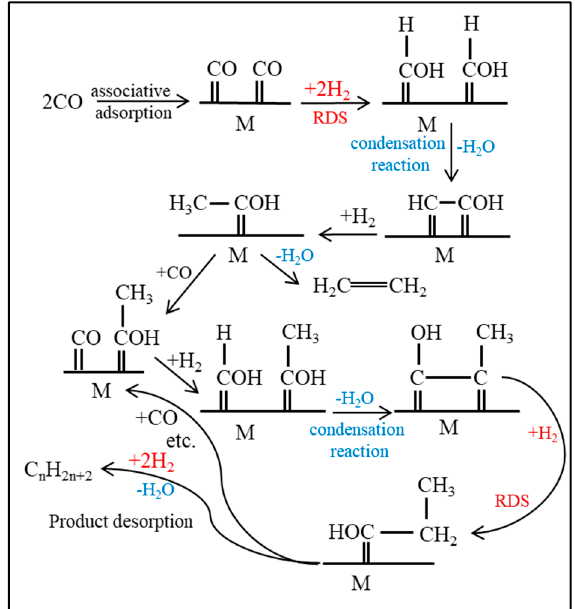
Figure 4. A proposed FTS route based on the enol mechanism.